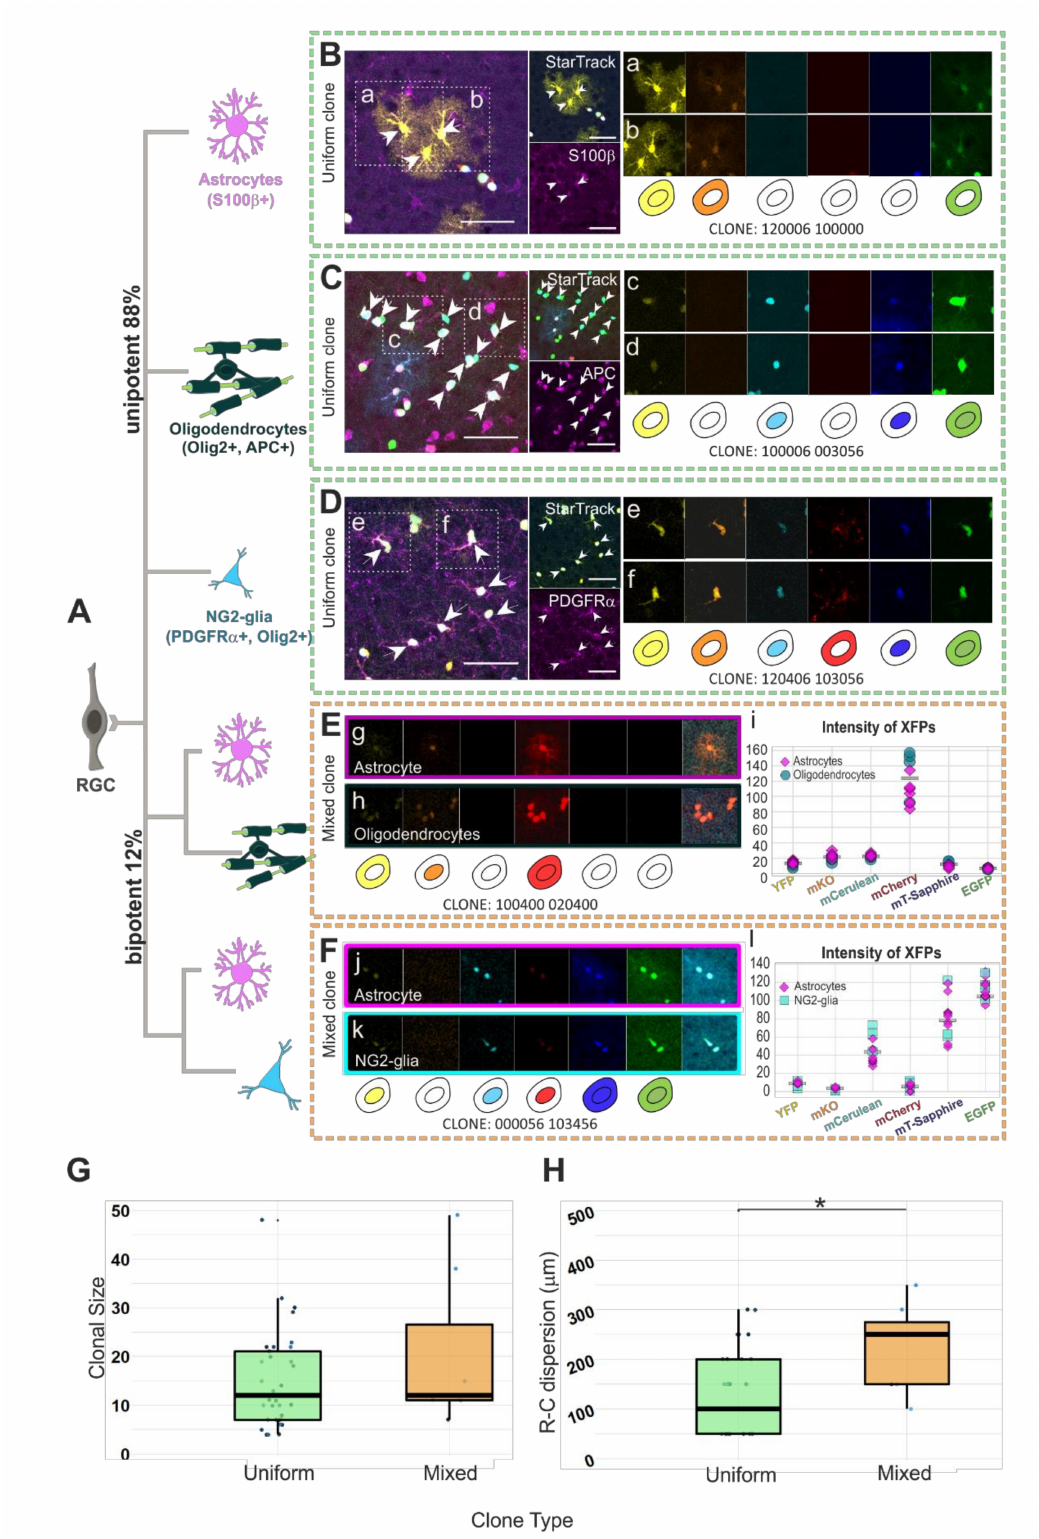
Figure 2. Clonal analysis of glial cell progeny derived from single pallial E14-RGC progenitors in lower cortical layers. ( A ) After targeting single RGC progenitors, we observed uniform clones (88%, n = 40 clones) composed of cells belonging to one glial lineage and mixed clones (12%, n = 6 clones) composed of two glial cell types. ( B ) Sibling StarTrack labeled astrocytes S100 β +. ( a , b ) Numeric and graphical representation of the color code of an astroglial clone according to the cytoplasmic/nuclear (123456 123456) presence of 1, YFP; 2, mKO; 3, mCerulean; 4, mCherry; 5, mT-Sapphire; and 6,